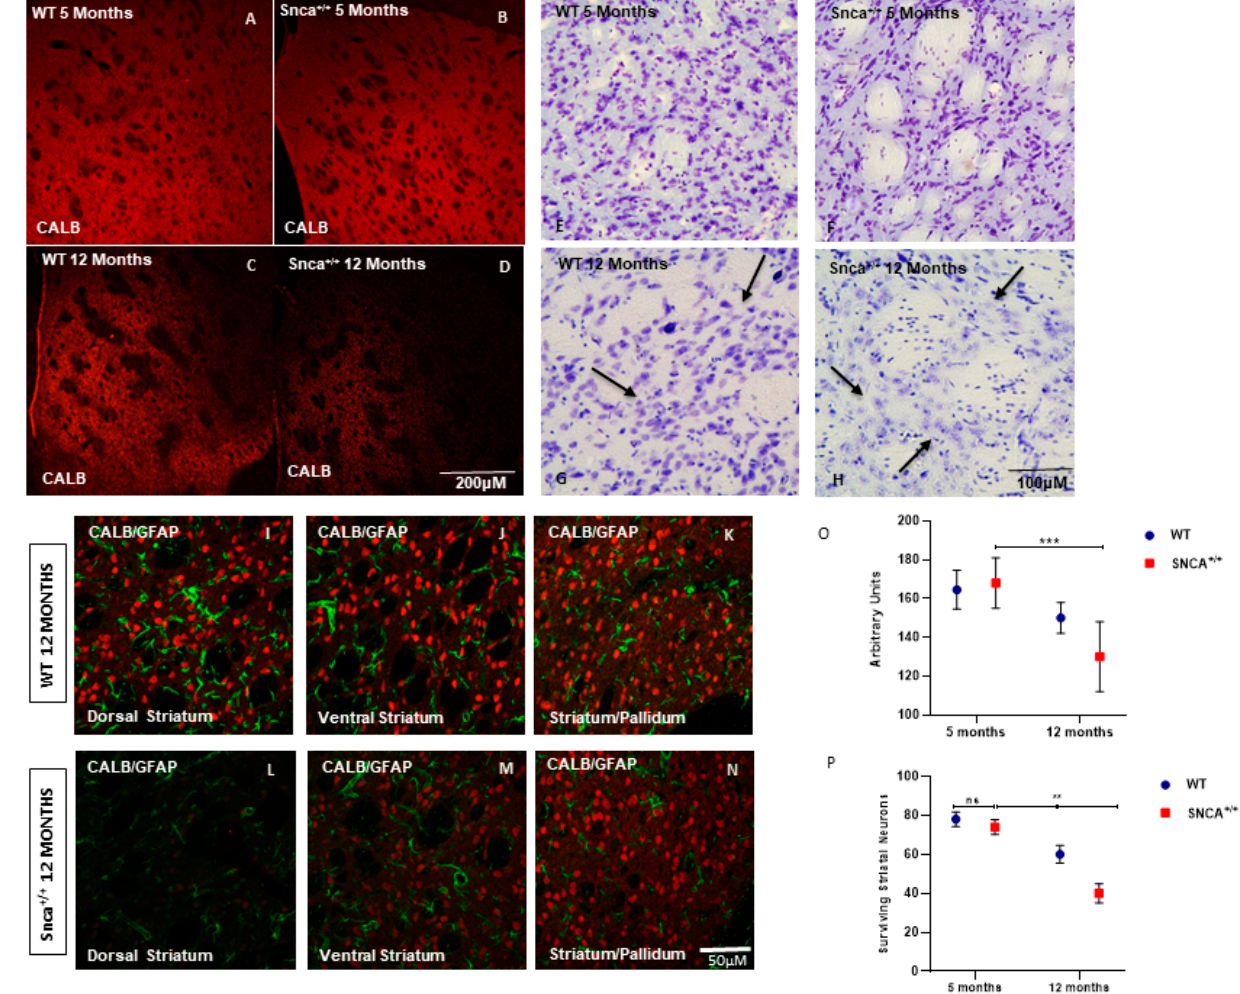
Figure 1. Striatum pathology. Confocal laser scanning microscopy images of single-label immunofluorescence for the marker of the medium spiny neurons, Calbindin D-28K (red), in the striatum of 5-month-old WT ( A ), 5-month-old Snca +/+ ( B ), 12-month-old WT ( C ), and 12-month-old Snca +/+ ( D ). Striatum Nissl staining. Representative images of coronal striatal slices ( E – H ) showing the dramatic reduction in surviving neurons in 12-month-old Snca +/+ ( arrows ) compared to WT littermate ( arrows ). WT 12 months: ( I ) dorsal striatum, ( J ) ventral striatum, ( K ) striatum/pallidum; Snca +/+ 12 months: ( L ) dorsal striatum, ( M ) ventral striatum, ( N ) striatum/pallidum; ( O , P ) Quantification of the number of striatal neurons labeled with CALB. A two-way ANOVA indicated a significant effect of genotype [F(1.24) = 7.86; ** p = 0.0098]; time [F(1.24) = 36.9 *** p < 0.001] and genotype X time interaction (F(1.24) = 3.49; p = 0.05). “ns” means “not